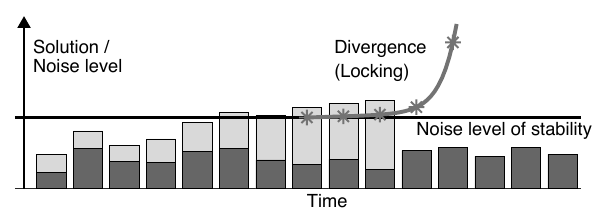
Figure 4. Bifurcating FEM-flow at a junction between four par- ticles (in grey), with grey arrows for the inflow and black arrows for the outflow. Possible configuration with a bifurcation angle at around 90  at the blunt element angle of 90  in (a). Numerically precarious configuration with an outflow twisted by 135  at the sharp element angle of 45  in (b).